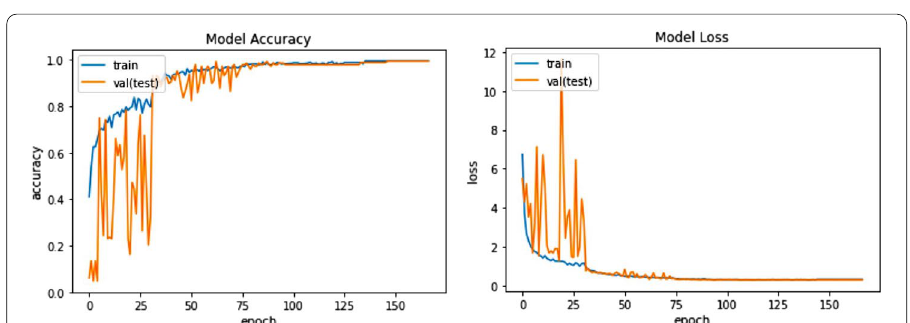
Fig. 7 Training and testing accuracy and loss of ARCH-1 with CK